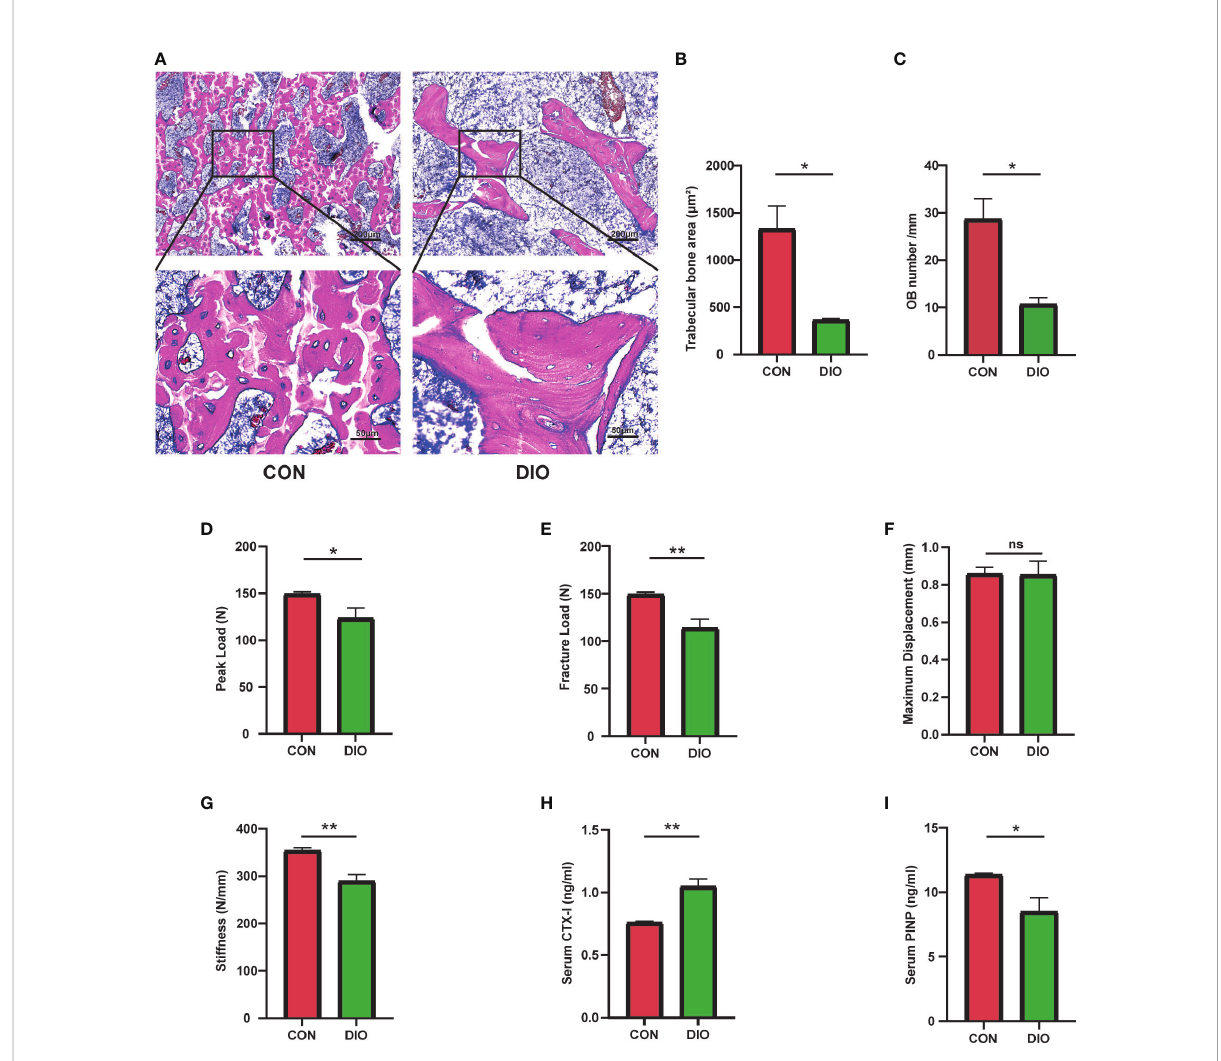
FIGURE 2 Changes in bone morphology, reduced bone mechanical properties, and inhibition of bone formation in DIO. (A) The bone tissue of distal femoral metaphysis was observed by H&E staining. (B) Trabecular bone area ratio. (C) Osteoblast numbers. (D – G) Parameters of the three-point bending test, including the peak load, fracture load, maximum displacement, and stiffness. (H, I) Serum levels of bone turnover biomarkers, including CTX-I and PINP. Data are expressed as the mean ± SEM. n = 6, *P < 0.05, **P < 0.01, ns, no signi fi